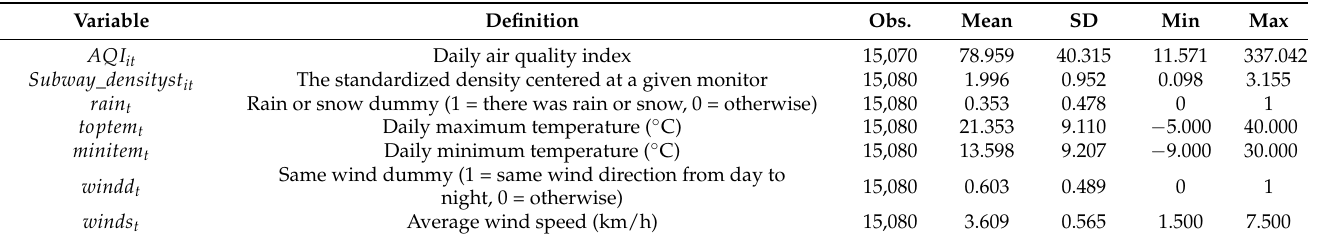
Table 1. Definition and summary statistics of the main variables involved in this